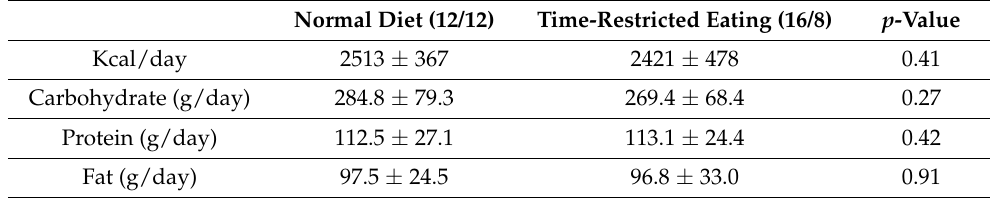
Table 2. Dietary Intake 1 .